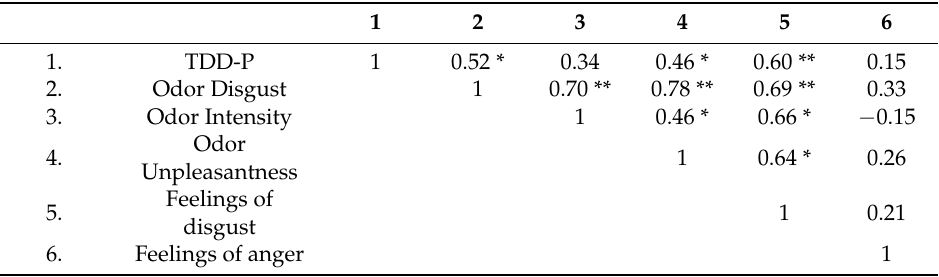
Table 4. Bivariate correlations Between TDD-P (Pathogen Disgust), Odor and Emotion Ratings for Pathogen Disgust Induction Only (n = 23) (Study